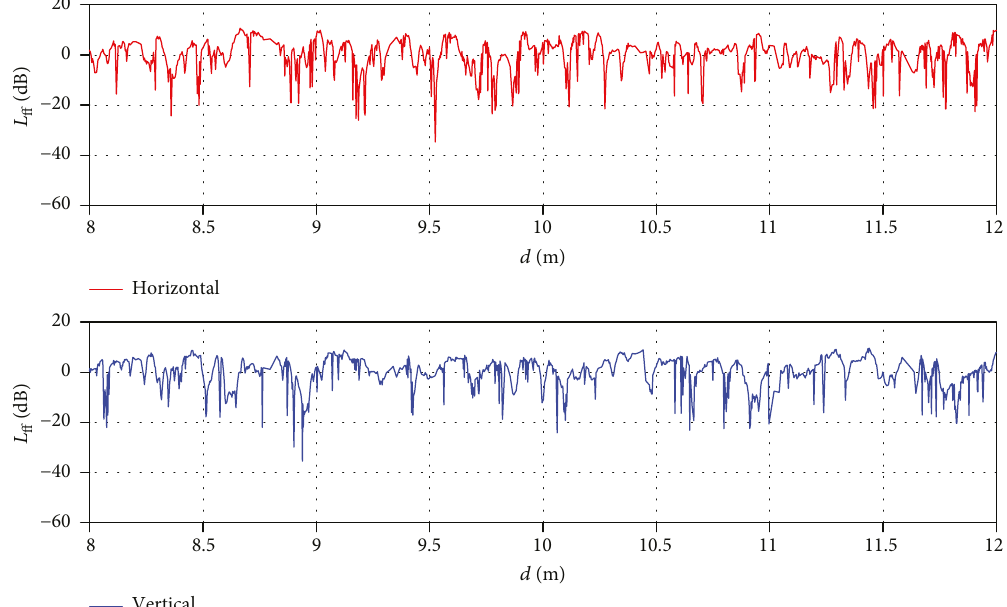
Figure 8: Magnitude of fast fading ( L